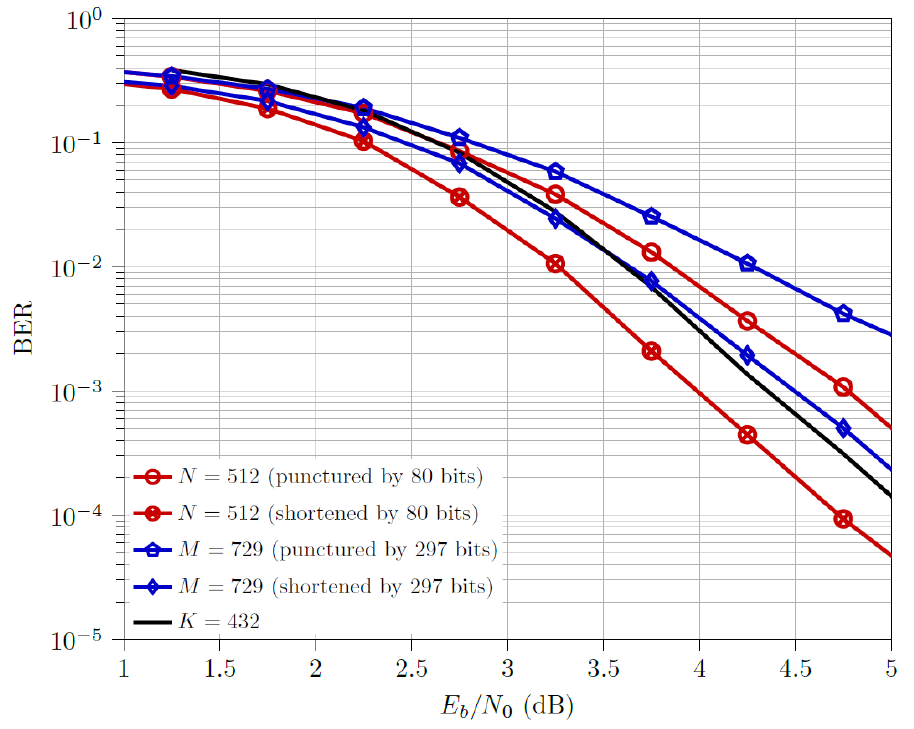
Figure 8. BER performance of Scenario 2 for R d =